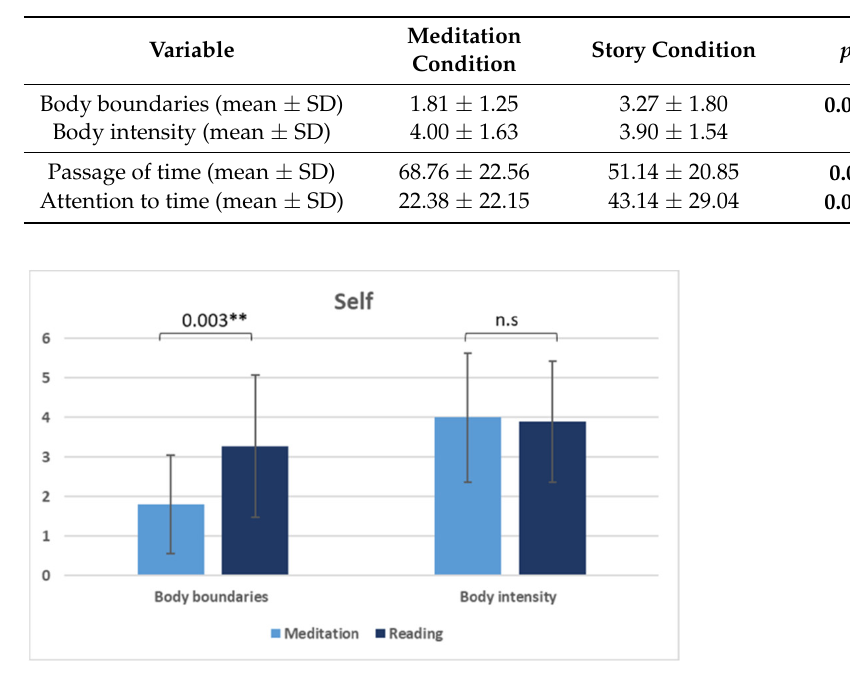
Figure 1. Mean values (error bars reflect SD) for the body boundaries and body intensity scales (y-axis values on a Likert-type scale between 0 and 6). The significant effect (**) for the variable body boundaries and the absent effect for the variable body intensity (not significant, n.s.), according to t -tests between the two conditions (meditation and reading), implies less salient body boundaries during meditation.